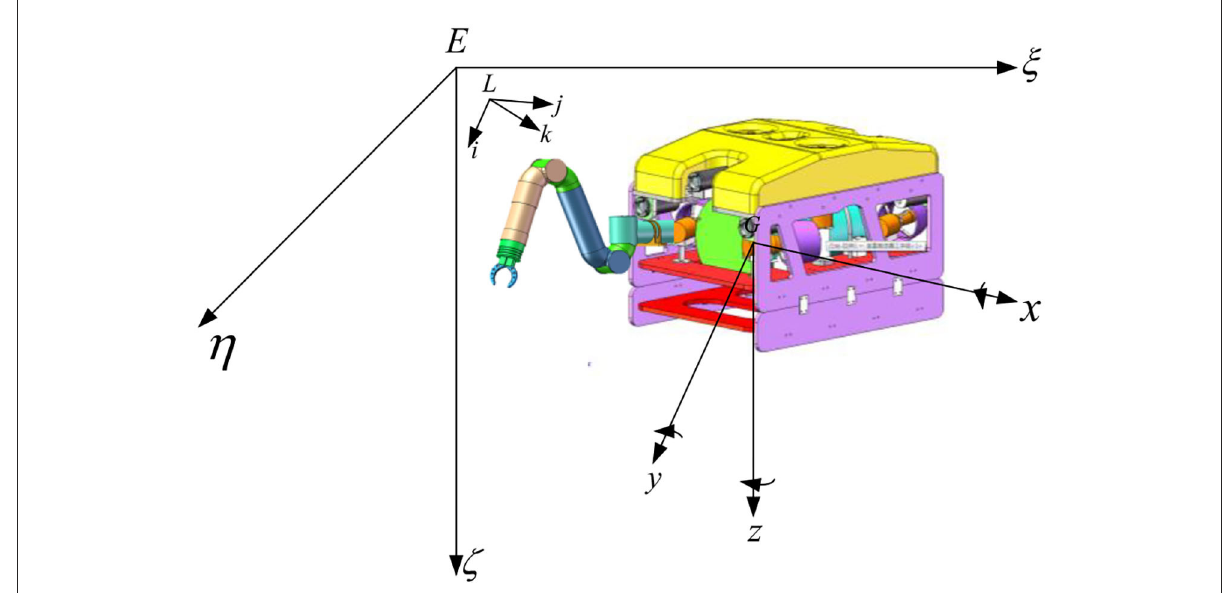
FIGURE1 UVMS system structure diagram.